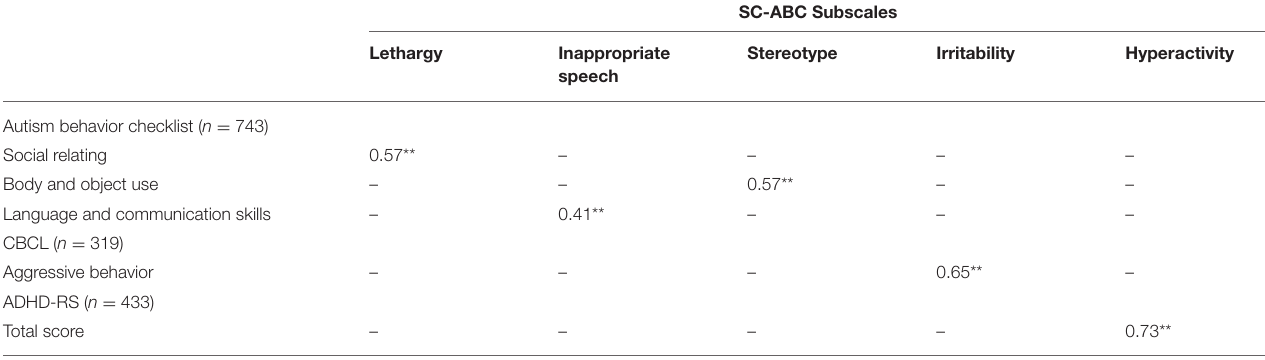
TABLE 3 | Spearman’s rank correlation coefficients for validity (entire sample).